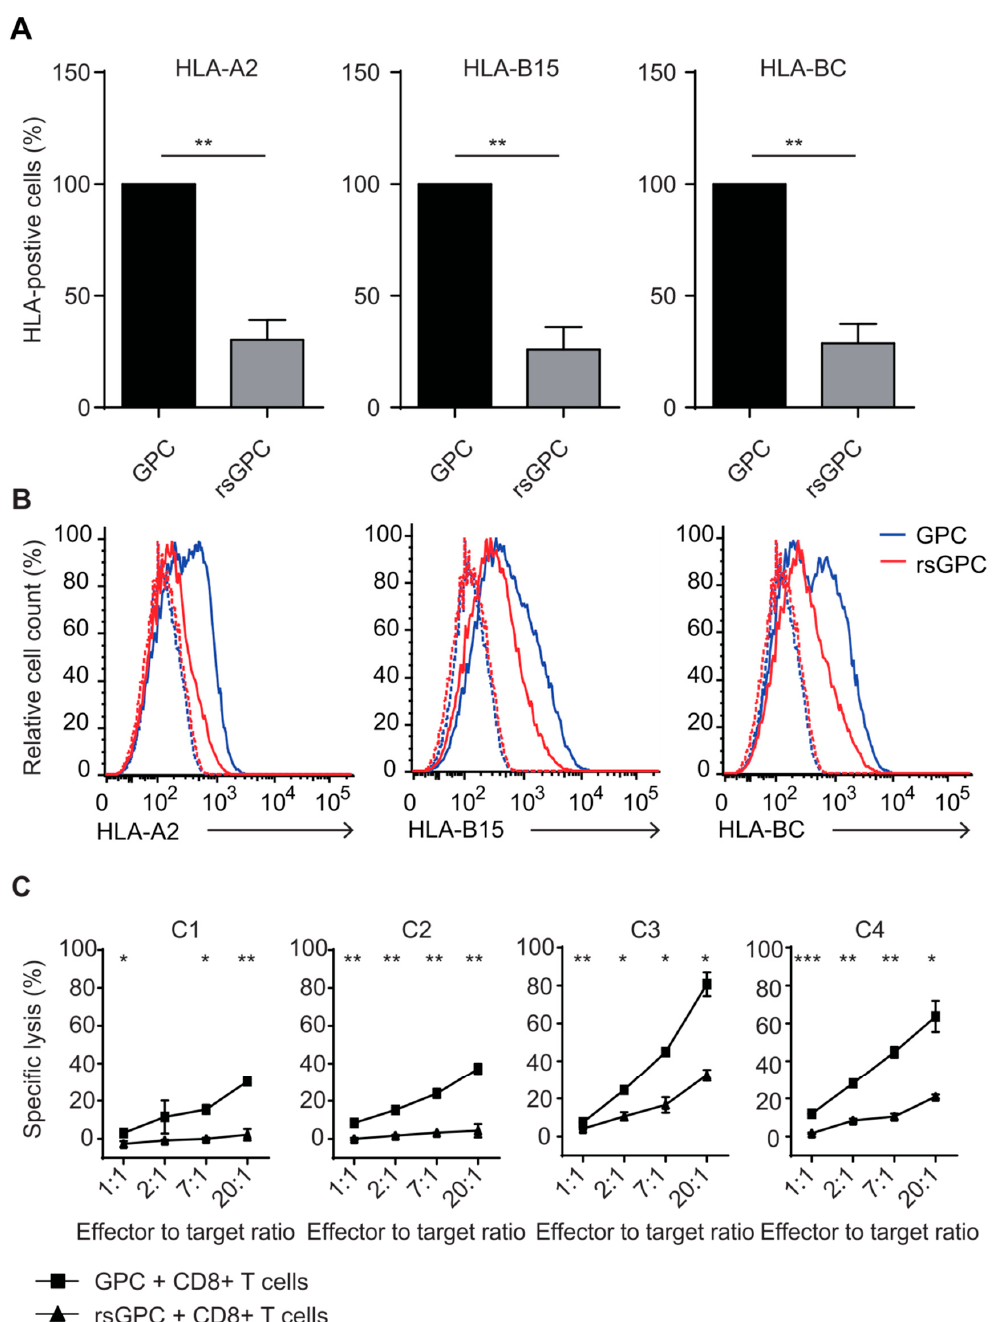
Figure 3. Fractionated radiation decreased MHC class I surface expression and recognition by CD8+ T cells. ( A ) Flow cytometric analysis of HLA molecules revealed a downregulation of HLA-class I, including the alleles HLA-A2, HLA-B15, and general HLA-BC alleles on the cellular surface of rsGPCs as compared to control GPCs. The results are depicted as % of HLA-positive cells ± SD of three independent experiments. ( B ) Flow cytometric analysis of HLA proteins on the surface of GPCs and rsGPCs revealed a downregulation of HLA-A2, HLA-B15, and pan-HLA-BC on rsGPCs. Depicted are histogram analyses of one out of three representative experiments. ( C ) HLA class I-partly matched CD8+ T-cell cultures were tested for their lysis potential of GPCs and rsGPCs in a 51 Cr release assay. Depicted are four CD8+ cultures, stimulated with rsGPCs that were tested for lysis of GPCs (squares) and rsGPCs (triangles) with effector to target ratios from 20:1 to 1:1. Cultures C1 and C2 did not lyse rsGPCs but exhibited lysis activity against control GPCs. * p < 0.05; ** p < 0.01; *** p <